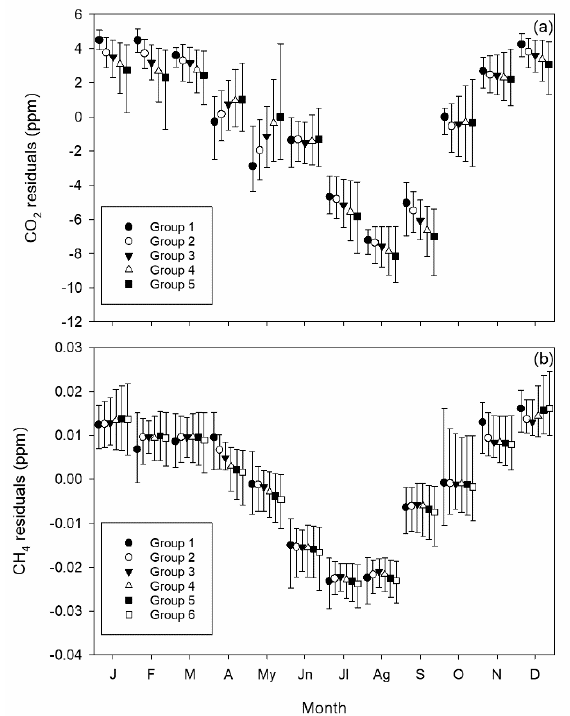
Figure 8. Monthly medians and interquartile ranges of detrended observations distributed following the groups presented in Figure 7. ( a ) CO 2 , ( b ) CH 4 .